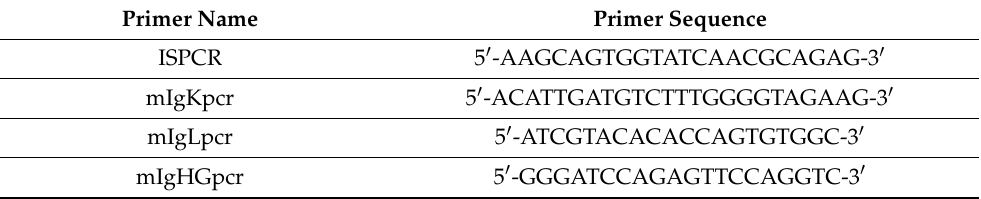
Table 2. The primers used in the PCR reactions. Along with the common forward primer (ISPCR), the primers for variable kappa (mIgKpcr), variable lambda (mIgLpcr) light chains, and variable heavy chain (mIgHGpcr) were utilized to amplify specific